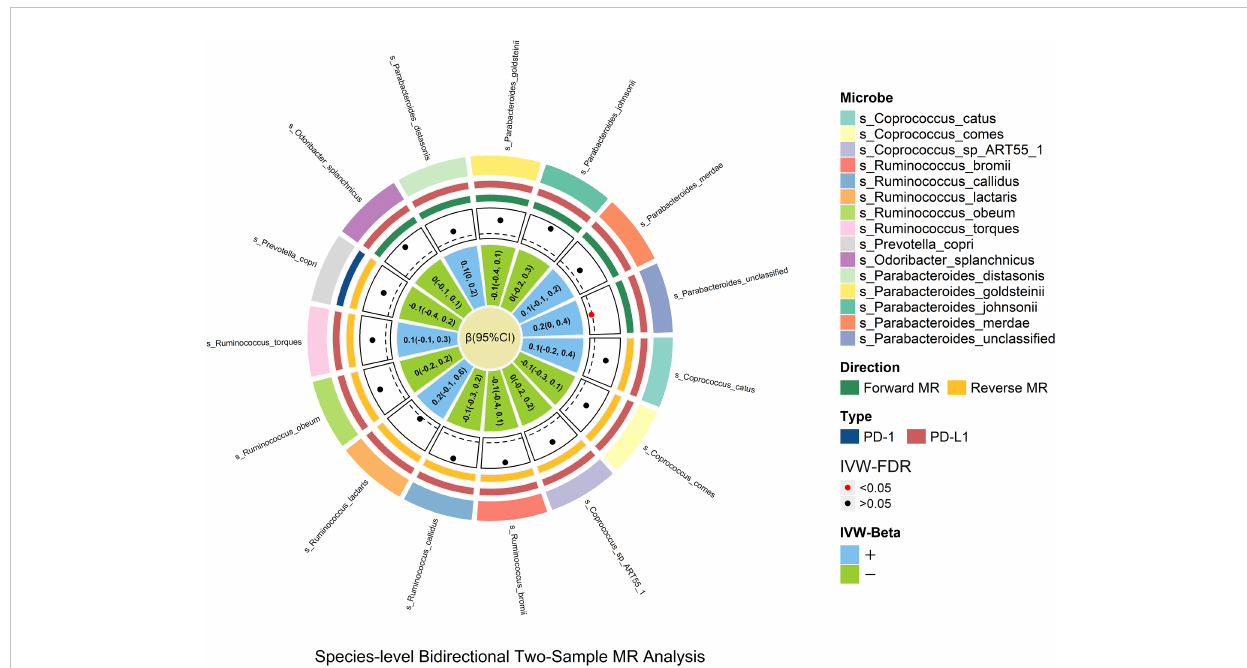
FIGURE 4 In the species-level bidirectional two-sample MR analysis, microbial features were pre fi xed with species(s). The selection of species-level microbes is based on the signi fi cant result of genus-level microbes. The MR estimates and 95% CI values are shown in the plot. The point of the plot indicates the P value of IVW, and red indicates signi fi cance (P FDR <0.05). The “ + ” and “ - ” in the legend indicate the direction of the estimate effect